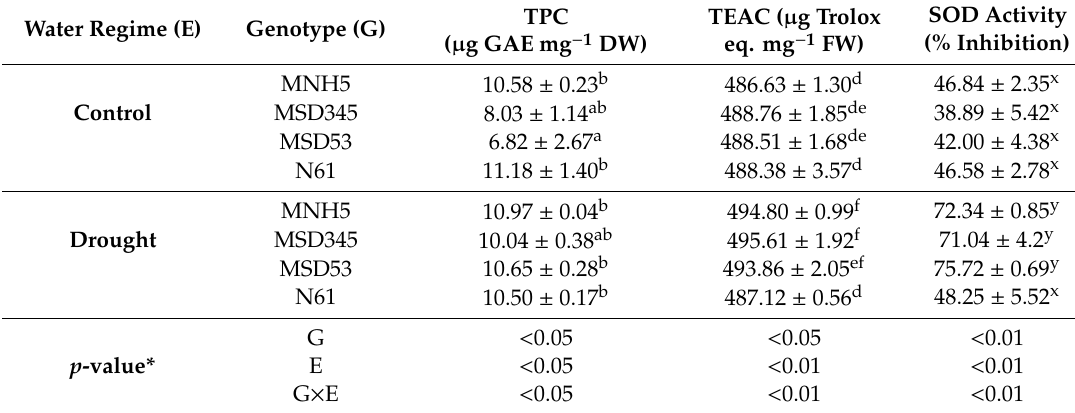
Table 2. Total phenolic content (TPC), Trolox-equivalent antioxidant capacity (TEAC), and superoxide dismutase (SOD) activity in the three multiple synthetic derivative lines (MSDLs) and their backcross parent, “Norin 61” (N61), under control and drought stress